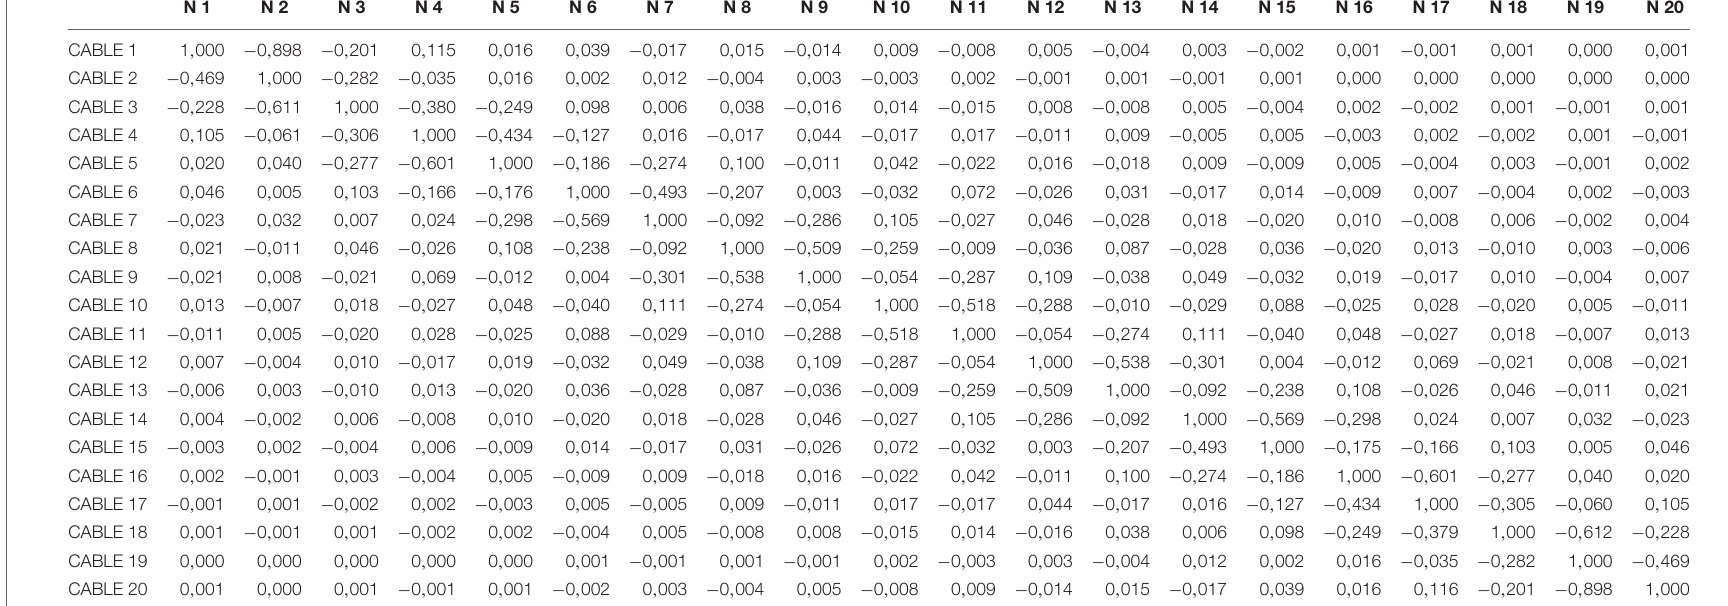
TABLE 3 | Influence matrix of the analyzed finite element model (unit: